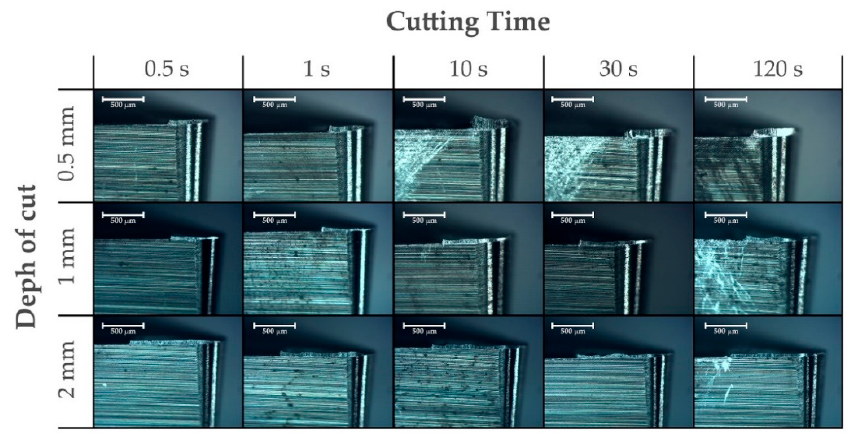
Figure 6. Evolution of the adhered material over the rake face from a vertical plane projected on the clearance face.